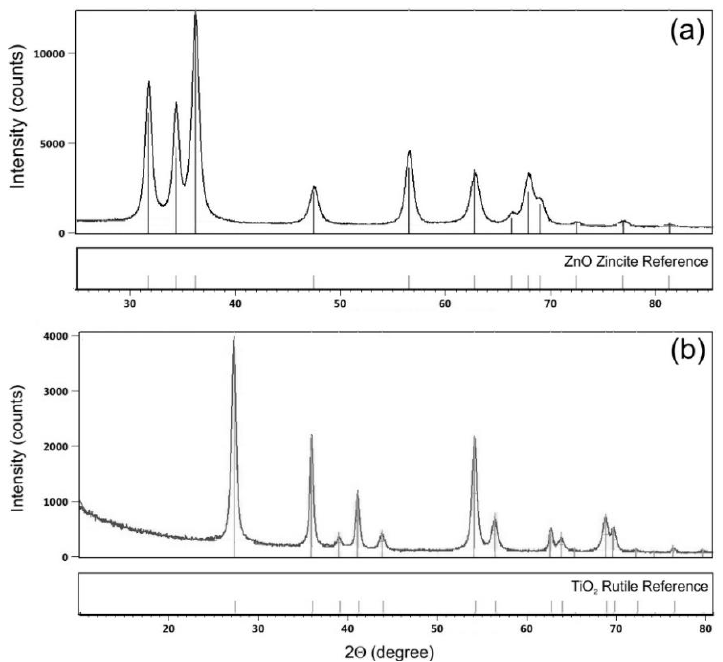
Figure 2. XRD patterns of ( a ) ZnO and ( b ) TiO2 NPs commercial dispersion.